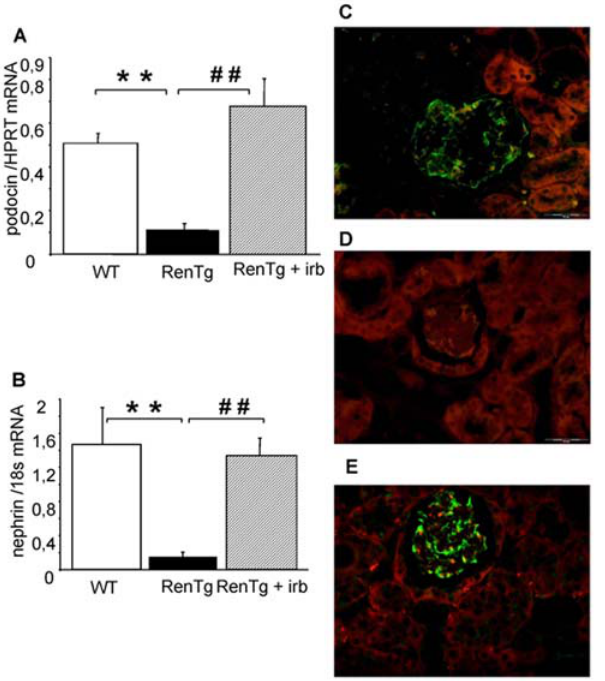
Figure 6. Reestablishment of normal podocyte phenotype after AT1 receptor antagonism. Quantitative RT-PCR analysis of the expression of genes involved in the podocyte structure such as podocin (A) and nephrin (B) in the renal cortex of wild type and RenTg mice before and after irbesartan treatment, and representative examples of podocin expression in glomeruli of wild type (C) and RenTg mice before (D) and after (E) irbesartan treatment. The expressions of podocin and nephrin in the RenTg mice returned to control values following irbesartan administration. Bar=50 m m. Values are mean 6 SEM; n=5, 9 and 13 for wild type and RenTg mice before and after irbesartan, respectively; ** P , 0,01 vs WT; ## P , 0,001 vs RenTg.